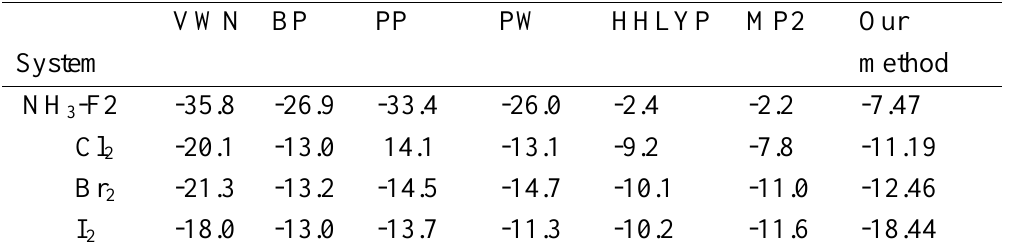
Table 5a : Comparison of the IE (in kcal/mol) values of NH and by other standard DFT and MP2 methods.